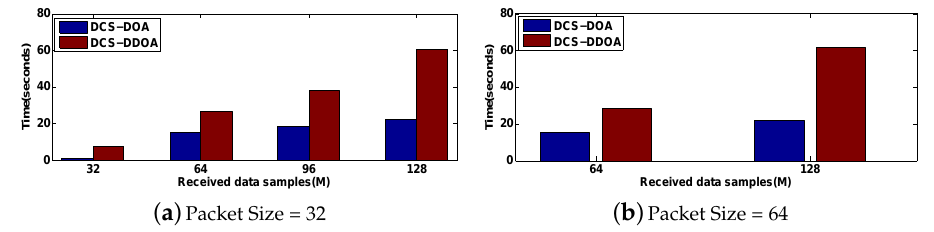
Figure 19. The computation time spent on one DOA estimate for DCS-DOA and